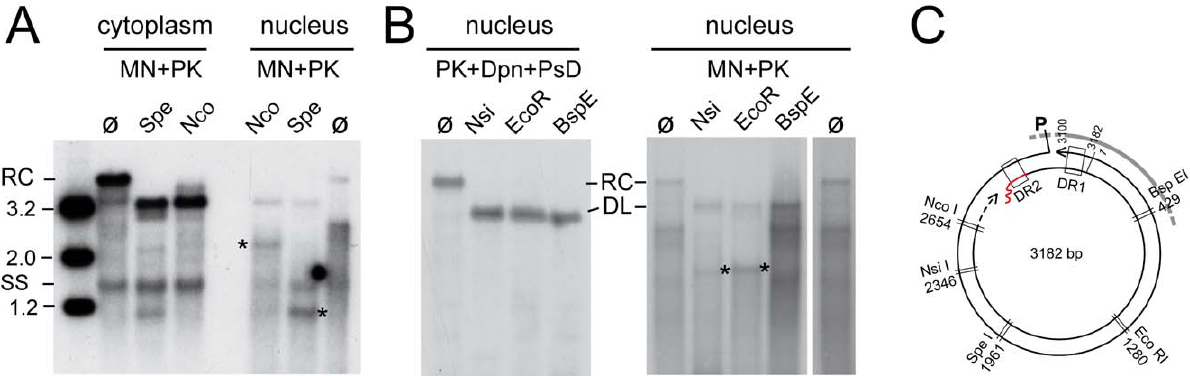
Figure 6. Restriction mapping of nuclear HBV rcDNA suggests genome region-selective MN accessibility. ( A ) Cytoplasmic versus nuclear MN-resistant viral DNAs. DNAs were isolated from HepG2 cells transfected with the surface-deficient HBV vector after prior MN plus PK treatment, and incubated with restriction enzymes Spe I and Nco I (ø, no restriction). Amounts equivalent to 10% of the total cytoplasmic fraction and 90% of the total nuclear fraction were loaded. ( B ) Total nuclear rcDNA versus MN resistant nuclear DNA. Viral DNA from isolated nuclei was prepared by either the PK plus Dpn I plus PsD procedure (total nuclear rcDNA), or after prior MN plus PK treatment (MN resistant nuclear DNA), and incubated with Nsi I, Eco RI or Bsp EI. Asterisks denote newly formed distinct fragments; lane ø on the right is a longer exposure of lane ø on the left. ( C ) Restriction map of HBV. The restriction sites probed in A and B are indicated. DR1 and DR2, direct repeats 1 and 2; P, covalently linked polymerase; wiggly red line, RNA primer at ( + )-DNA 5 9 end. Together, the patterns can consistently be explained if MN treatment removed a defined region from the rcDNA that approximately encompasses position 3000 to 500.